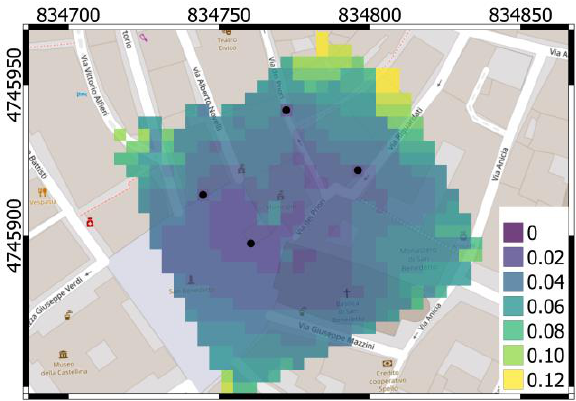
Figure 6. Estimated precisions [m] along Y axis.